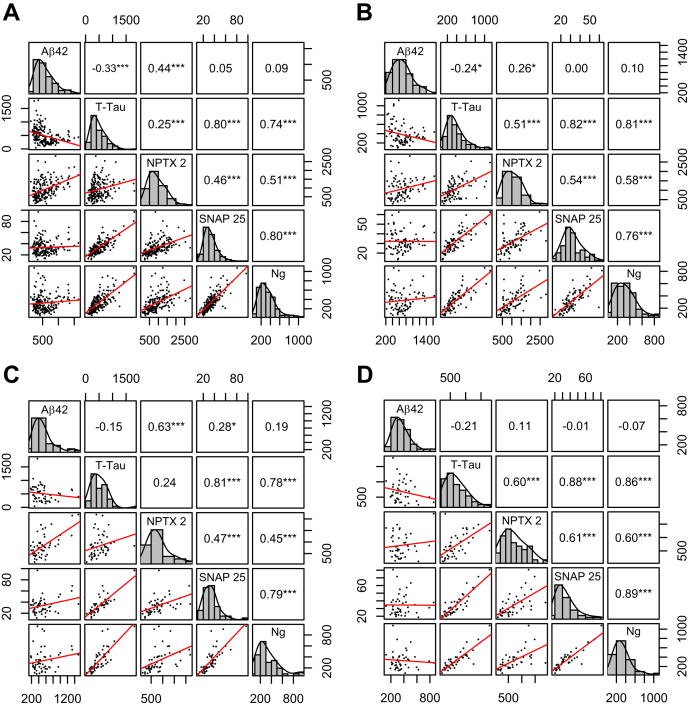
Relationship of biomarkers across diagnoses. Correlations between biomarker in the overall sample (A), or restricted to Normal Cognition (B), MCI (C), or AD patients (D). On the diagonal are labeled histograms for each biomarker. On the lower-left half of the plot, each scatterplot corresponds to the biomarker vertically above it on the x-axis and the biomarker horizontally to the right on the y-axis. The upper-right half of the plot shows the R correlation coefficients for each biomarker pair, with stars denoting the level of significance. *P < .05, **P < .01, ***P < .001.